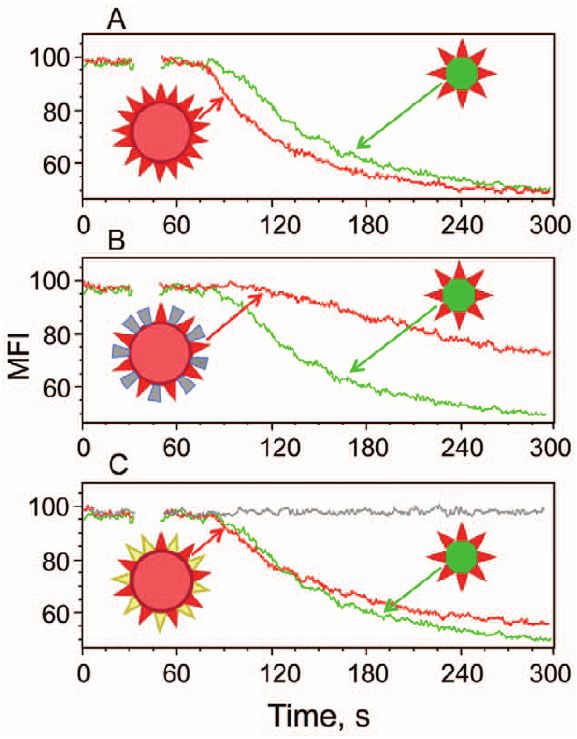
Figure 5. The dependence of TCR-mediated signaling kinetics upon the density of cognate and noncognate pMHC displayed on QD of different sizes. Time-dependent accumulation of intracellular Ca 2 + in Fura Red-labeled 68A62 CTL in response to stimulation with 10 nM QD of different sizes presenting various combinations of cognate, noncognate and inactive pMHC ligands. The comparison of the stimulatory potency of (IV9-HLA-A2) 40 /QD(620) (A) or (IV9-HLA-A2) 10 (GL9-HLA-A2 mut ) 30 /QD(620) (B) or